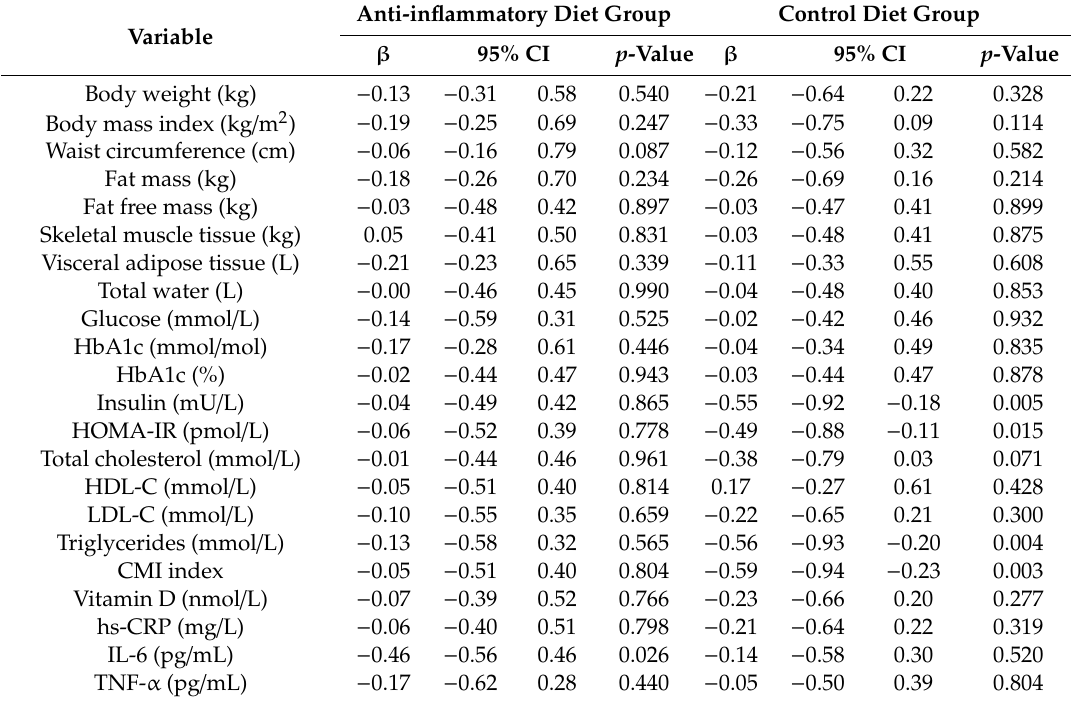
Table 5. Regression analyses of the participants’ anthropometric, cardiometabolic, and inflammatory parameters after 6 months of dietary intervention as dependent variables and changes in the DII ® scores as independent